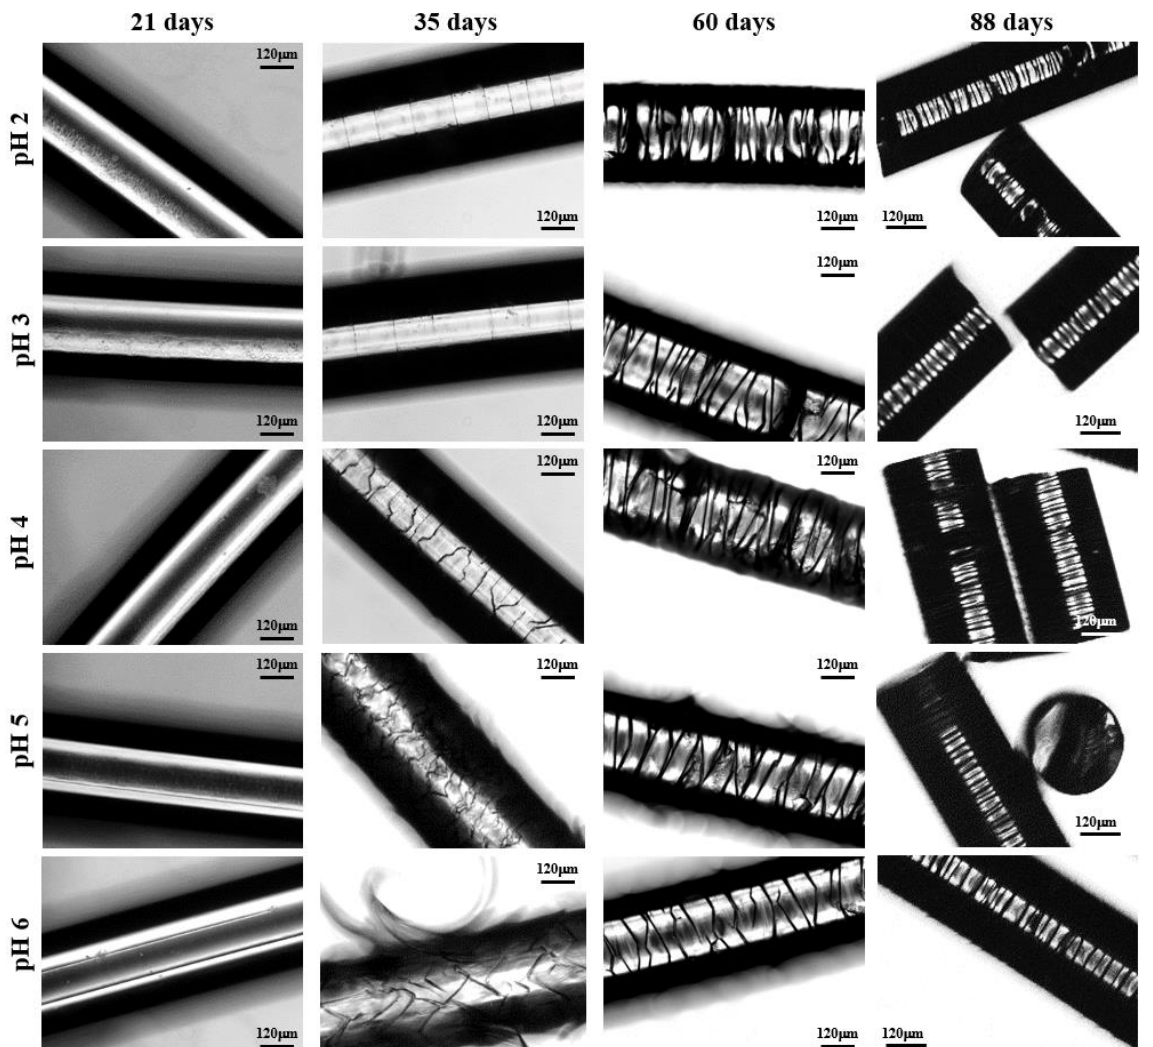
Figure 10. Optical micrographs showing the morphological changes of γ irradiated GL- b -[GL- co -TMC- co -CL]- b -GL samples during exposure for the indicated times to the indicated acidic media at 37